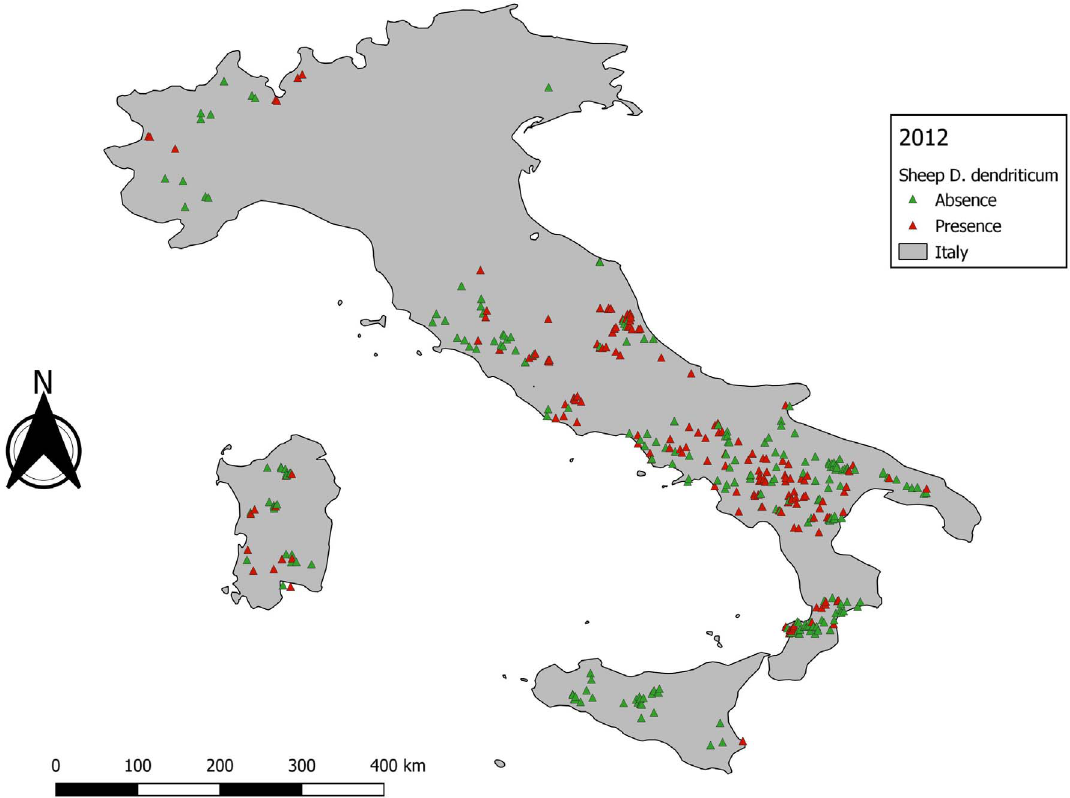
Figure 6. Data distribution for Dicrocoelium dendriticum